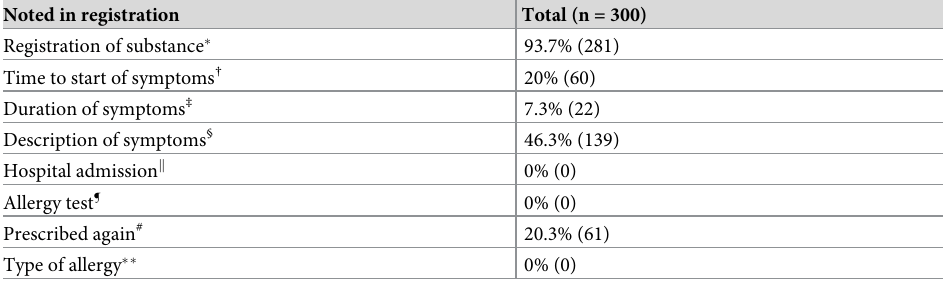
Table 2. Analysis of a random selection of antibiotic allergy registrations for completeness and correctness.